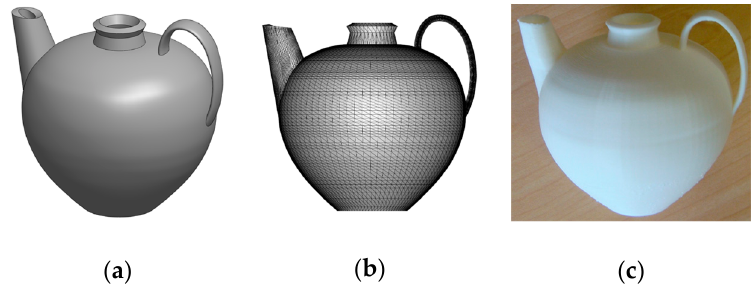
Figure 20. Ewer model. ( a ) Rendered solid CAD model; ( b ) triangulation model; ( c ) 3D printed model.